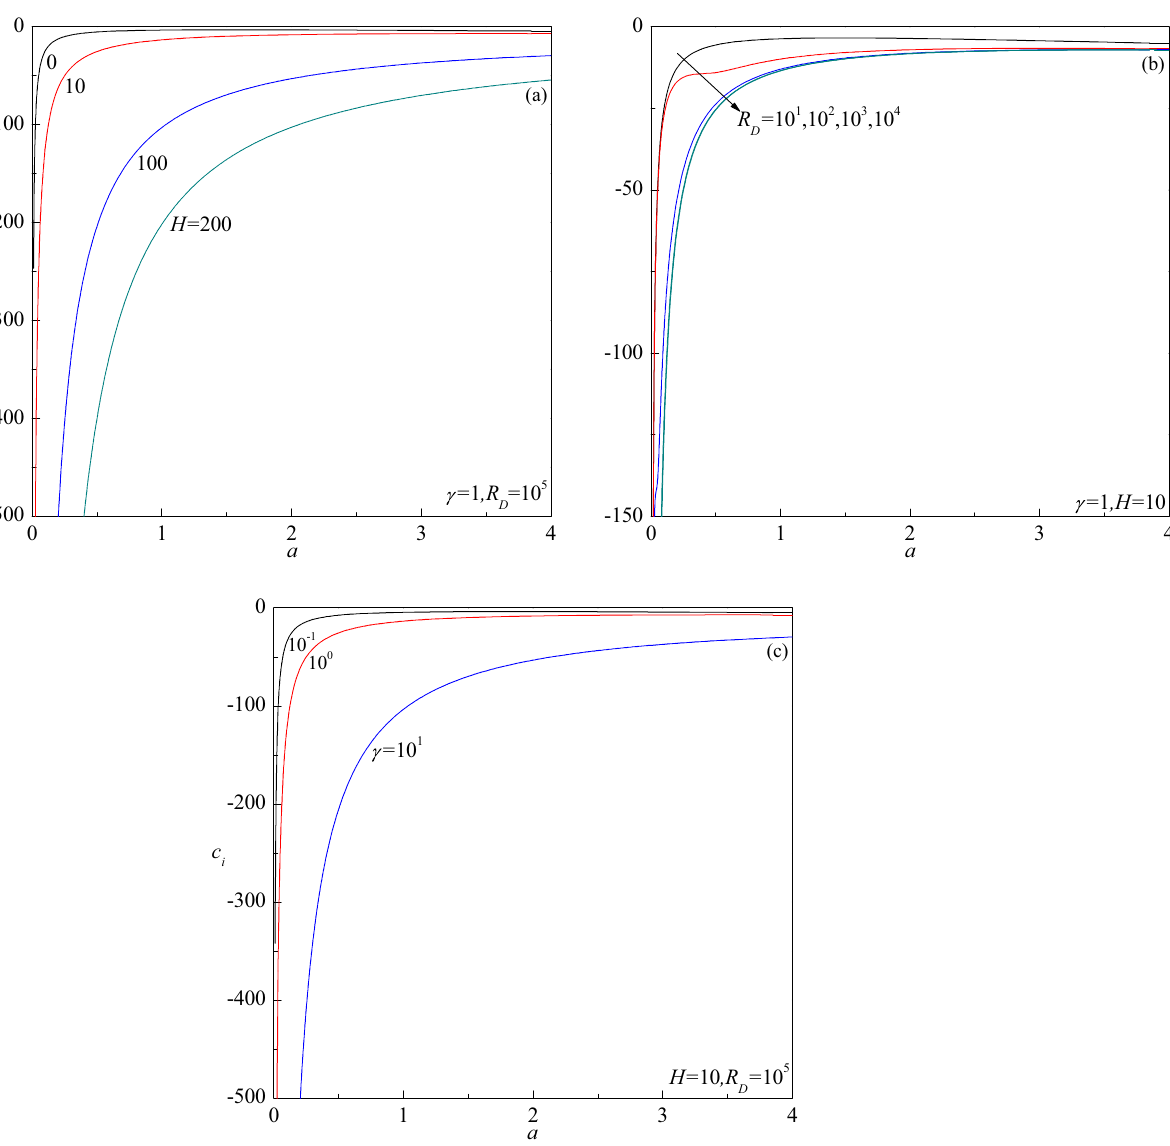
Figure 2. Growth rate c i versus a for different values of ( a ) H , ( b ) R D and ( c ) Le , in the absence of a second- diffusing component ( R S = 0